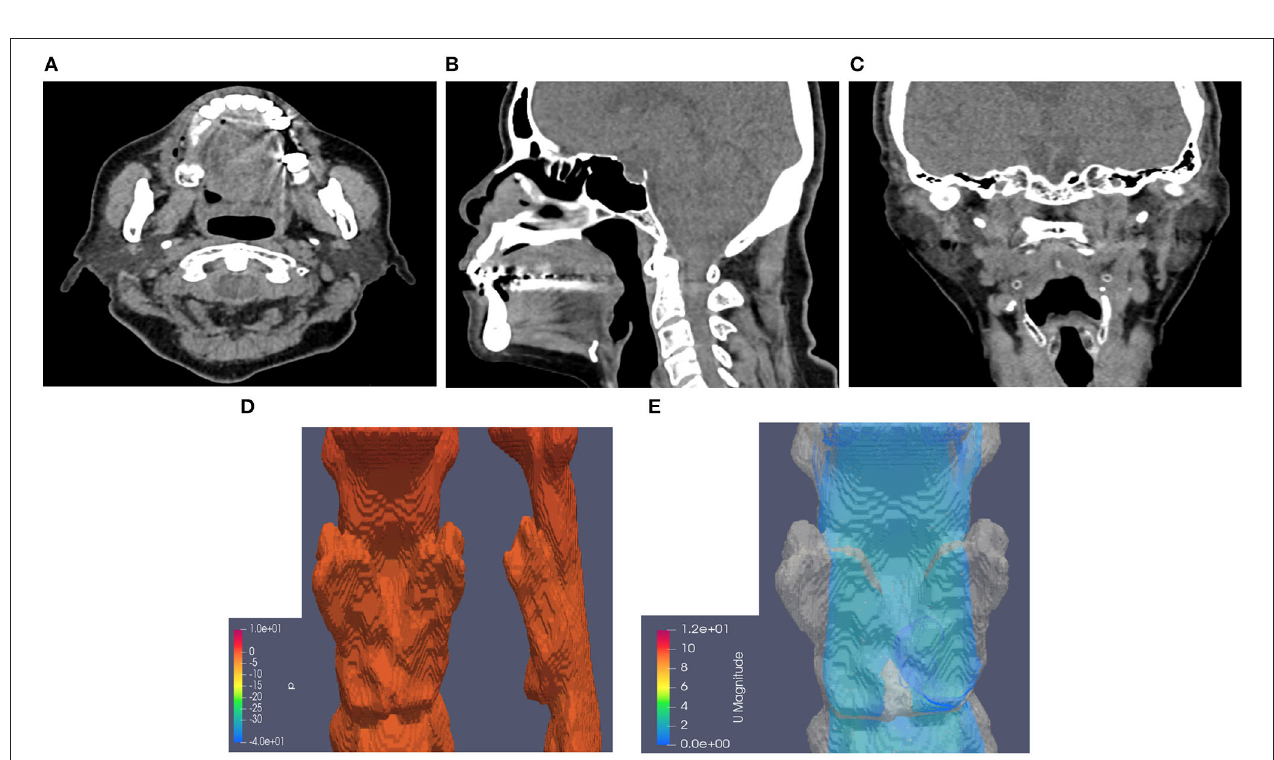
FIGURE 2 | Neck CT with computational fluid dynamics study of the 82-year-old female showed CTL12. (A) Axial view. (B) Sagittal view. (C) Coronal view. (D) Airway pressure of 1.28Pa. (E) Airflow velocity of 0.8 m/s.